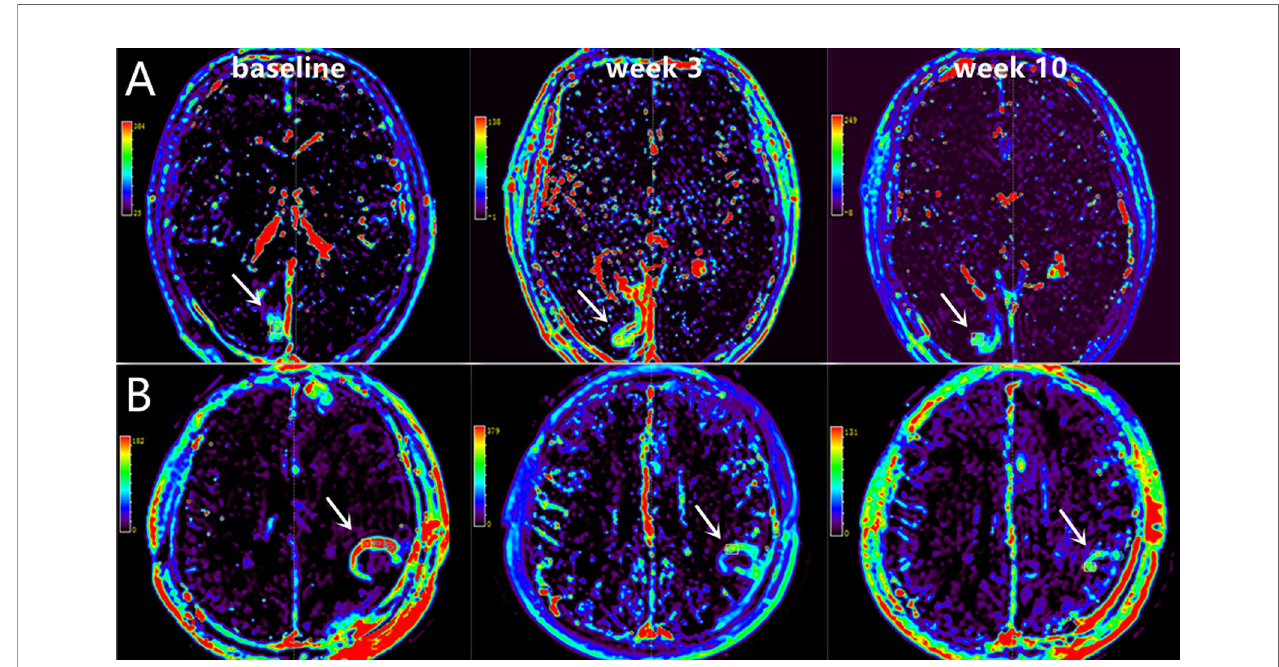
FIGURE 5 | Representative DCE-MRI scans at baseline, week 3 and week 10 in two patients with OS of 41.92 months [ A , Male, 53 years old, decrease in K trans =13.12 (min -1 )] and 22.18 months [ B , Male, 48 years old, decrease in K trans =-139.82 (min -1